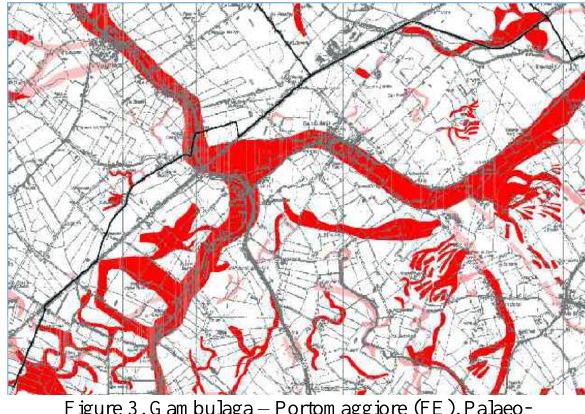
Figure 3. Gambulaga – Portomaggiore (FE), Palaeo- watercourses and floods (extract from the map Luetti, Veronese,